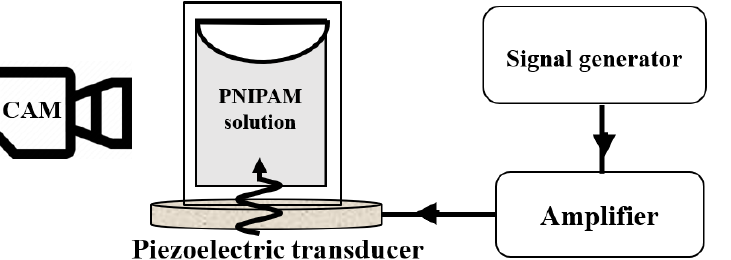
Figure 6. The experimental setup consists of a signal generator, amplifier, and piezoelectric transducer as well as a camera for visualization of the PNIPAM solution.